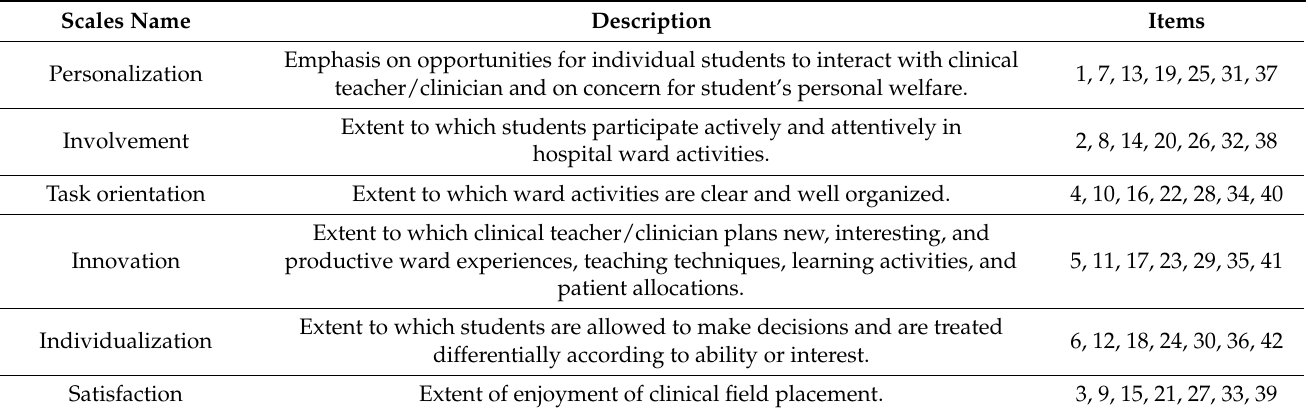
Table 1. Definition of the CLEI scales (source: Chan, 2001, p. 629